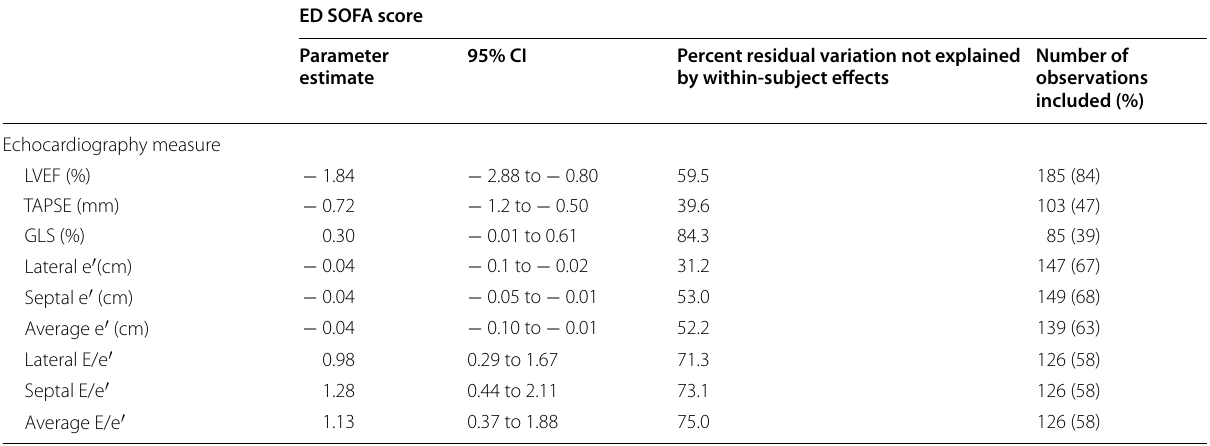
Each row represents a single linear mixed-effects model with the outcome being repeated measures (at 0, 3 and 24 h) of the cardiac function parameters listed in column 1 and the parameter estimate for ED SOFA score (covariate parameter estimates not shown) LVEF left-ventricular ejection fraction; TAPSE tricuspid annular plan systolic excursion; GLS global longitudinal strain; e ′ mitral annular velocity; E/e trans-mitral inflow velocity/mitral annular velocity